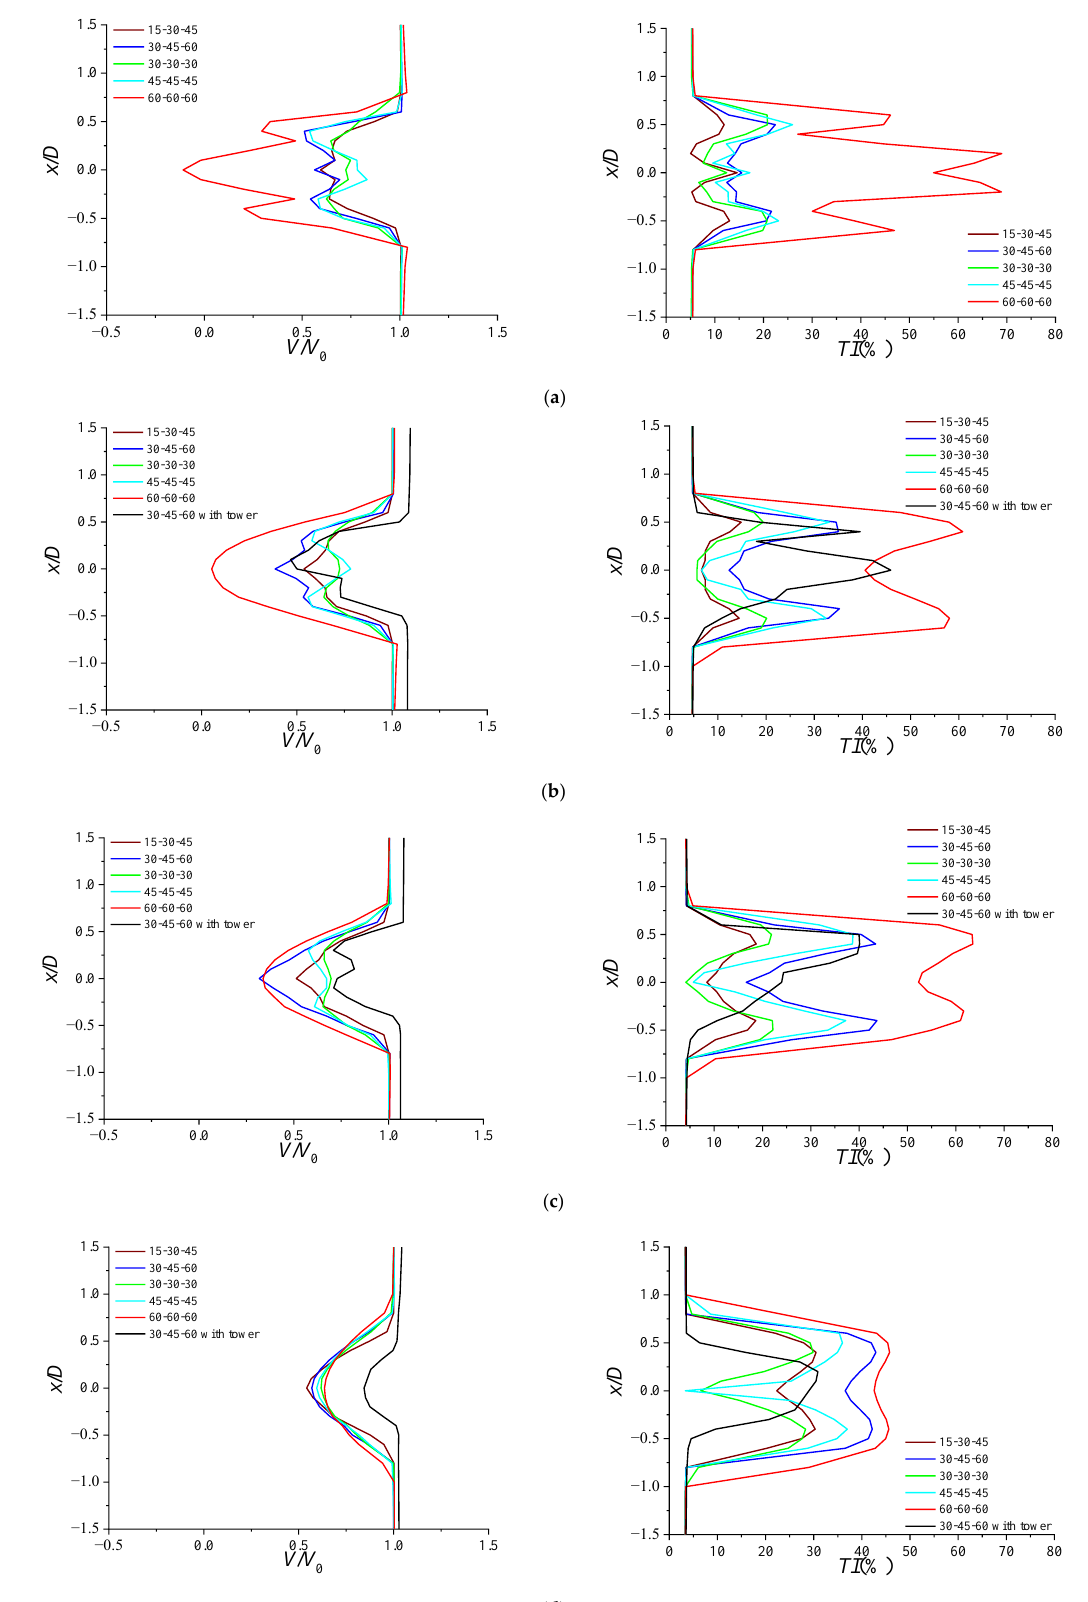
Figure 16. Profiles of velocity ( left ) and turbulence intensity ( right ) for the five ASWT rotors at TSR = 1.5 in the central x - z plane: ( a ) z / D = 1.0; ( b ) z / D = 3.0; ( c ) z / D = 5.0; ( d ) z / D = 10.0.